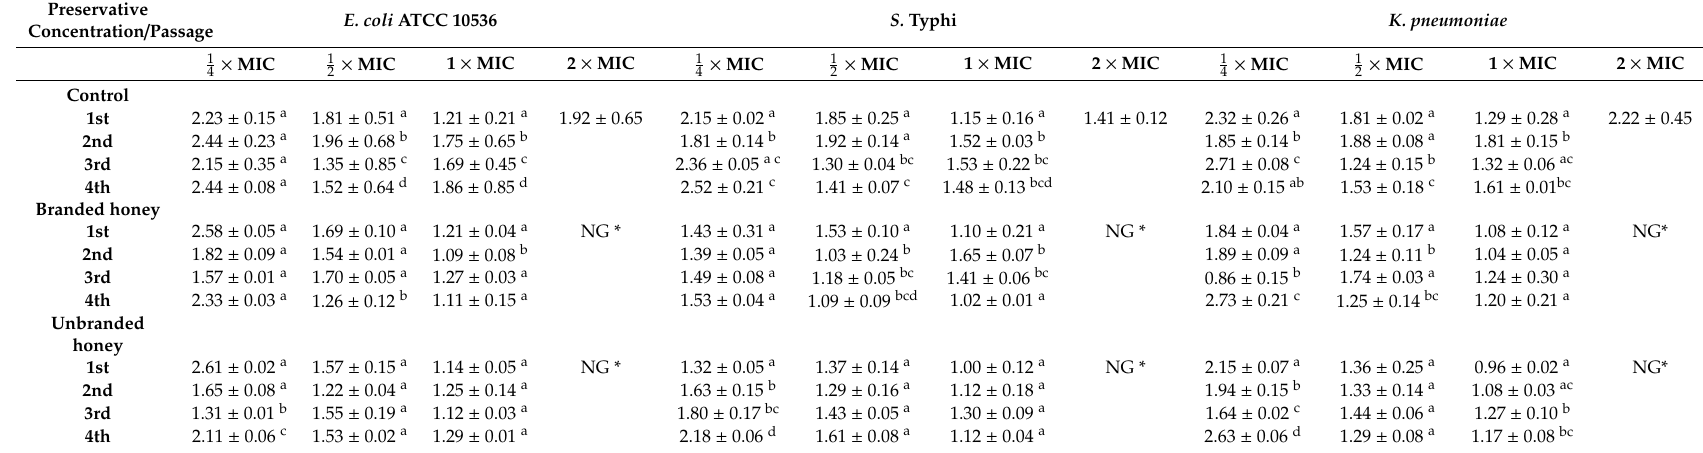
* Growth variation after each passage in shown as the ration between OD 600nm at T 24 and OD 600nm at T 0 (ODT 24 / ODT 0 ). NG: no growth. Data are representative of three replicates ± SD. (Branded honey against E. coli and K. pneumoniae : 1 1